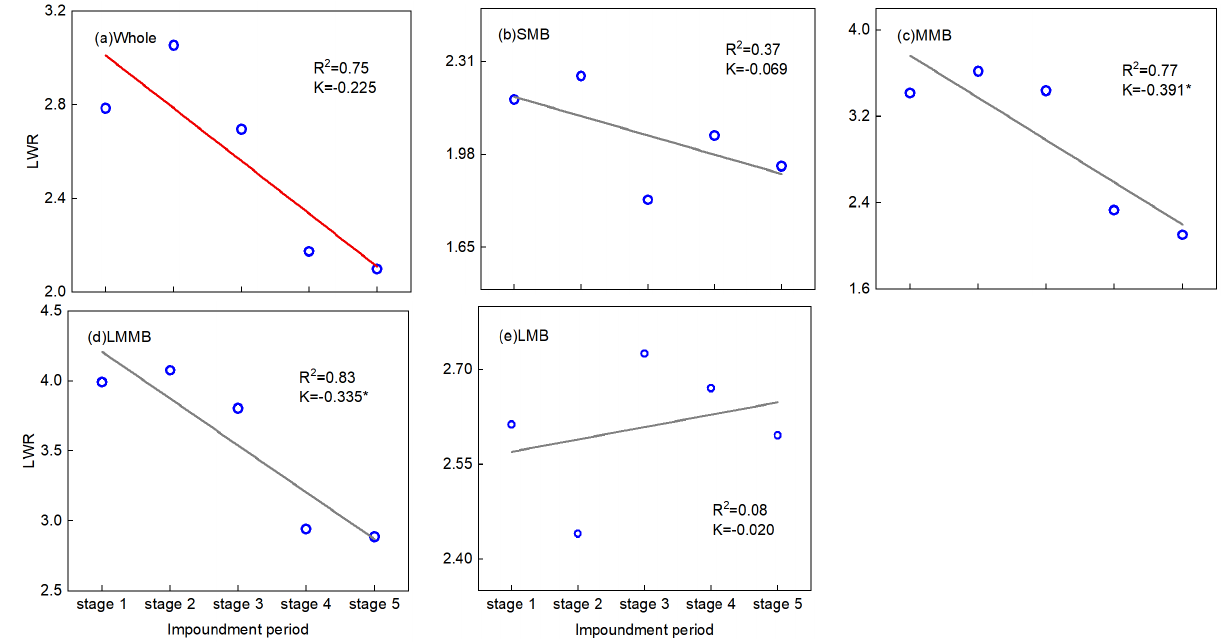
Figure 5. LWR changes in MCBs with different sizes: (a) whole, (b) SMBs, (c) MMBs, (d) LMMBs and (e) LMBs.